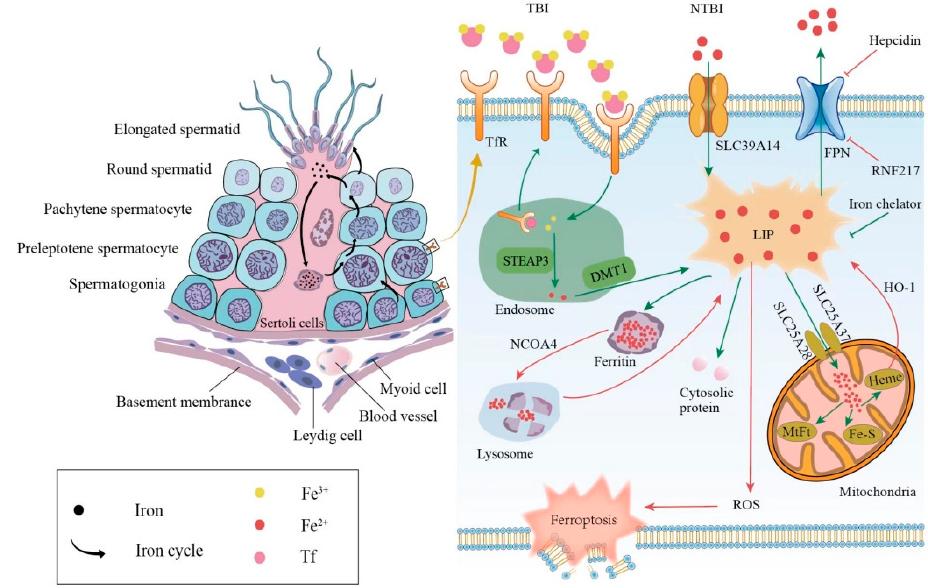
Figure 1. Relationship between iron metabolism and ferroptosis during spermatogenesis. The left side shows the iron circle in the process of normal spermatogenesis. The right side shows cellular iron metabolism and results caused by iron overload. TBI, transferrin-bound iron; NTBI, non-transferrin-bound iron; Tf, transferrin; TfR, transferrin receptor; DMT1, divalent metal transporter 1; FPN, ferroportin; LIP, labile iron pool; MtFt, mitochondrial ferritin; HO-1, heme oxygenase 1; NCOA4, nuclear receptor coactivator 4; ROS, reactive oxygen species.